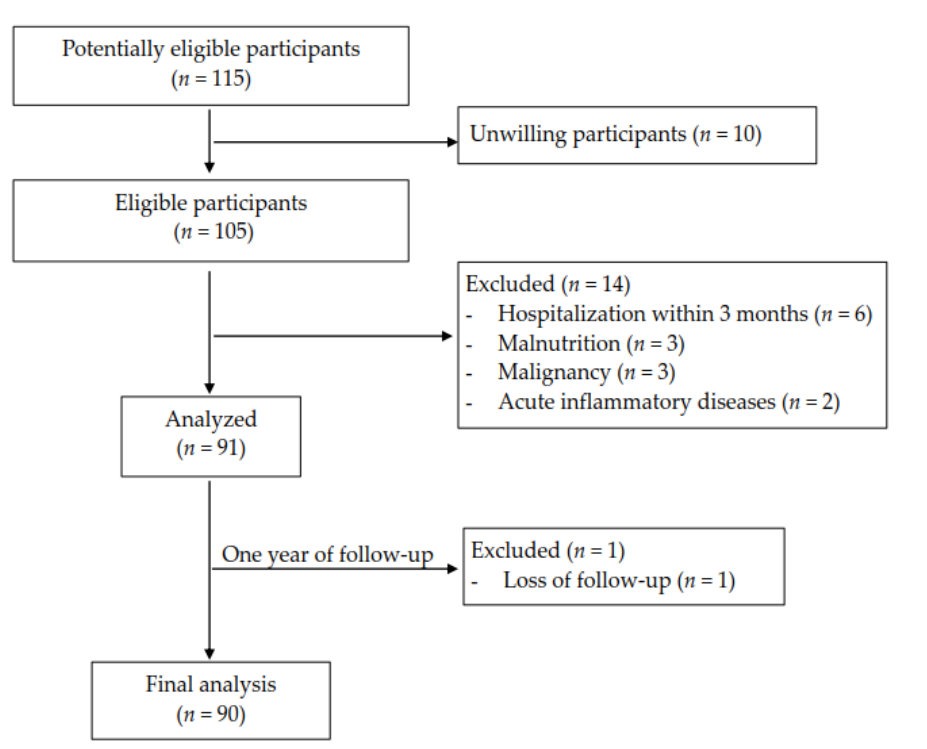
Figure 1. Study design and flowchart of patient selection.